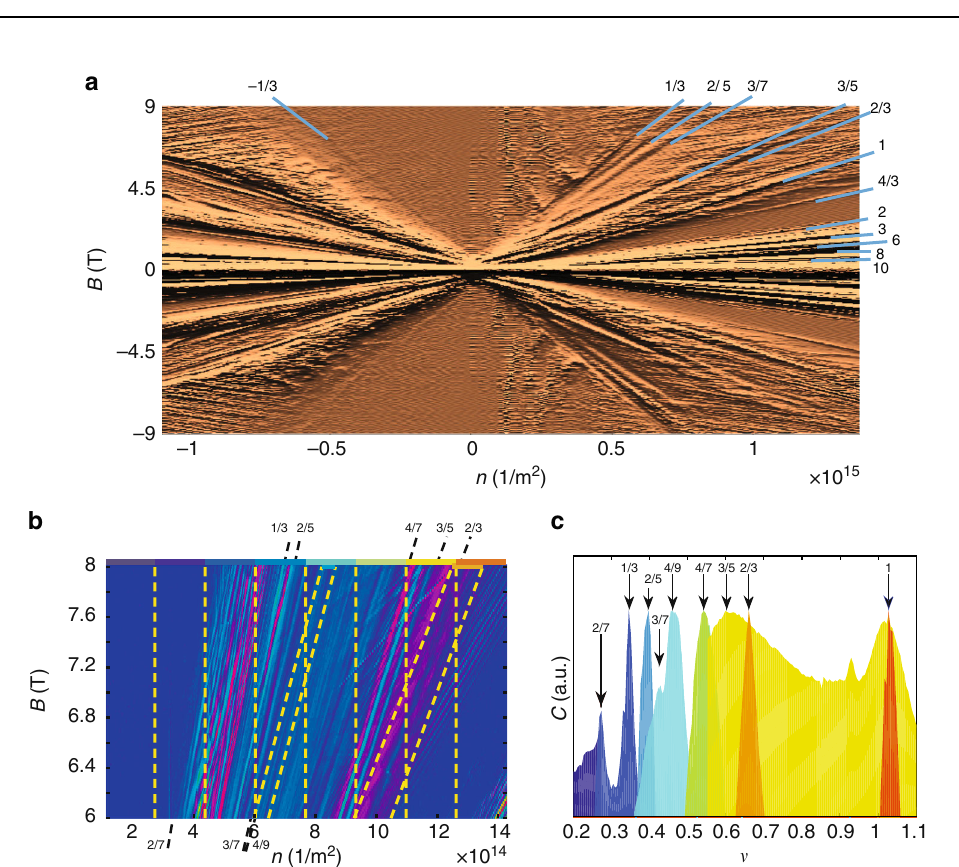
Fig. 2 Magnetoconductance/transconductance measurement. a The derivative of logarithmic differential magnetoconductance w.r.t. n , i.e., δ log( G d )/ δ n , of sample EV* (Table 1), displayed as a Landau fan diagram on the B vs. charge density n plane. The blue lines at ν = nh / e B identifying regular QH states ν = {2, 6, 10}, broken symmetry states ν = {0, 1, 3} originating from lifting spin and valley degeneracies, and FQH states ν = { − 1/3, 1/3, 2/5, 3/7, 3/5, 2/3, 4/ 3}. b Modulation of transconductance phase Arg{ g m } measured for sample EV over charge density n ( V g up to 15 V) at magnetic fi elds between 6 and 8 T ( fi lling factor ν = 1 is reached at the lowest right corner). The data are divided into ten regions, each marked with a color bar at the top of the stripe: we use eight vertical stripes of equal size and two inclined stripes which are de fi ned in order to improve the contrast of fringes at ν = 3/7 and ν = 2/3. The correlation analysis has been performed separately in each region. The correlation function h ( ν ) speci fi es the structure of these fringes w.r.t. the slope δ n / δ B equaling to the fi lling factor ν . The black dashed lines off the borders indicate FQH states with the marked fractional fi lling factor. c The scaled cross- correlation function c ( ν ) = h ( ν )/ h ( ν ) max , for all values of ν = 0.2 … 1.1, identifying fractional fi llings {2/7, 1/3, 2/5, 3/7, 4/9, 4/7, 3/5, 2/3}, in agreement with our magnetoconductance measurements; see the Supplementary Note 4 for further analysis. The color of the distribution refers to the color code of the analyzed regions in Fig. 2b. The peak values are marked with the corresponding fractional fi lling factors. Further FQH states are displayed in inverse differential conductance data in Fig. 3 (see also Supplementary Note 5). The measurement was performed at mixing chamber temperature of 20 based on numerical derivative of logarithmic differential con- features coming from spatially modulated charge density due to ductance δ log G d / δ n (Fig. 2a), or on lockin measurements of g m ( B , disorder potential and corresponding to fi lling factor ν . These V g ) (Fig. 2b). Both FQH and QH states, localized on disorder fringes have been treated using a cross-correlation analysis potential landscape, are observed as additional sets of parallel described in the Supplementary Note 4. lines in our transconductance scans. The slope of the fringes varies in non-monotonic fashion, which is indicative of the